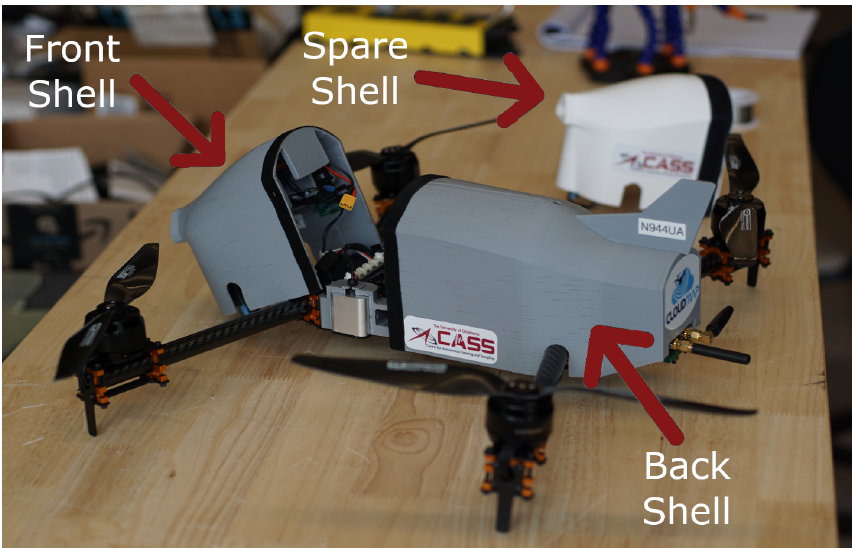
Figure 5. Side view picture of the CopterSonde UAS illustrating the modular parts of the 3-D-printed shell. The front shell is shown unmounted and a spare front shell is shown in the background to exhibit the ease of interchangeability of the CopterSonde’s shell. Table 2. Technical specifications of the weather sensors mounted on the CopterSonde according to the manufacturers. Sensor iMet-XF bead thermistor HYT-271 MS5611 Type Temperature Humidity Absolute pressure Sensing element Bead thermistor Capacitor MEMS a Range − 90–50 ◦ C 0%–100% 10–1200mbar Response time b ≤ 2s ≤ 5s ≤ 8 . 22ms Resolution 0 . 01 ◦ C 0 . 1% 0 . 065–0 . 012mbar Accuracy b ± 0 . 3 ◦ C ± 0 . 1% ± 1 . 5mbar Sampling rate 20Hz 20Hz 20Hz Protocol I 2 C I 2 C